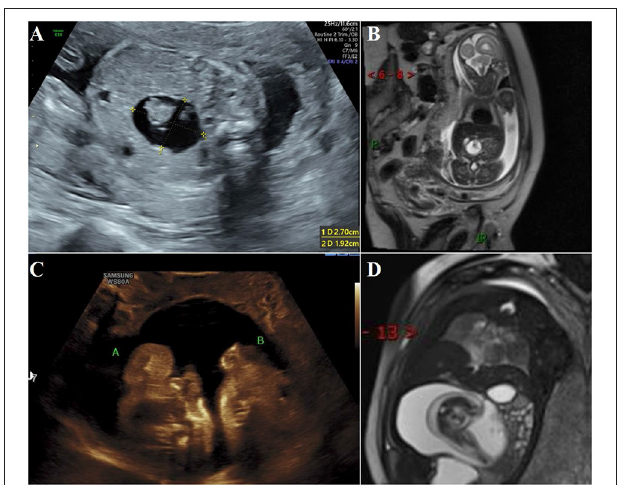
FIGURE 1 | During antenatal examination, the parasitic fetus was found by ultrasound and MRI. (A) Ultrasound examination at 22 gestation weeks showed mixed density shadow of the right upper abdomen of the fetus; (B) MRI at 22 gestation weeks showed a long T1 long T2 signal foci measuring 2.4 × 1.9cm near the midline area of the right upper abdomen of the fetus. The boundary was clear and the shape was regular. There are short cord-like short T2 signal foci in the lesion; (C) At the ultrasound examination at 37 gestation week, two parasitic fetuses were found; (D) MRI at 37 gestation weeks showed a round long T1 long T2 signal focus measuring 11.1 × 8.7 × 6.4cm near the midline area of the right upper abdomen of the fetus, with clear boundaries and regular morphology. Fetal structures can be seen in the lesion, and adjacent tissues are compressed.